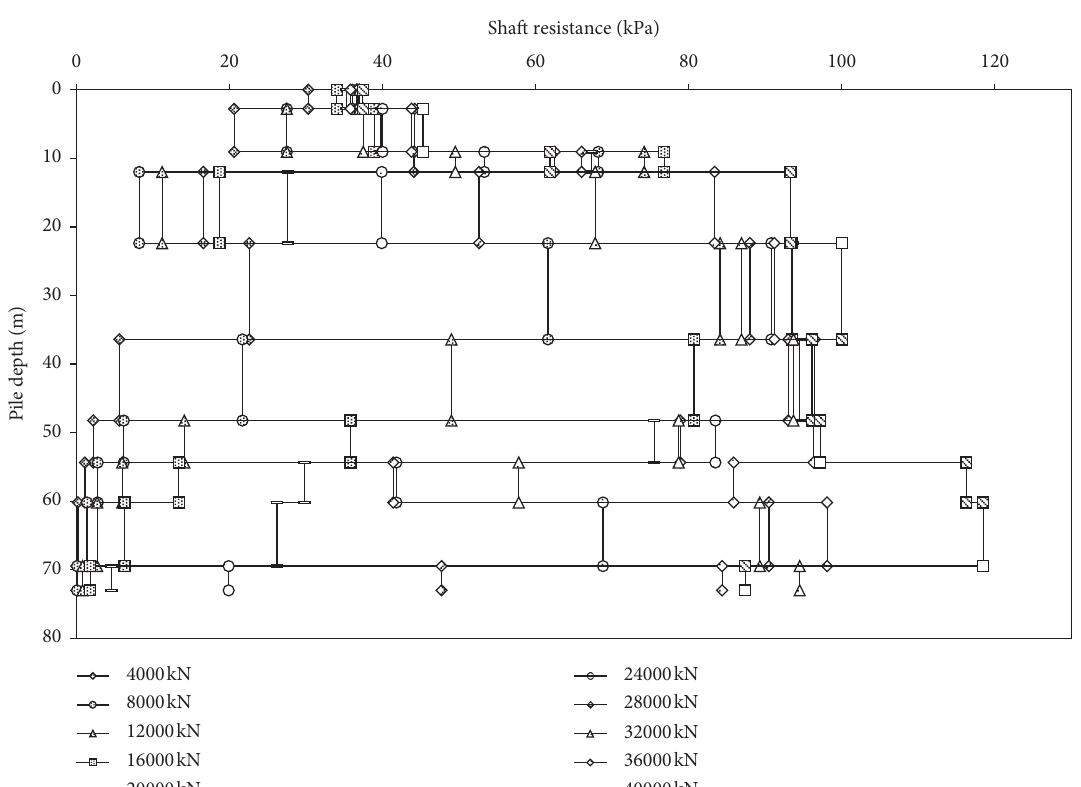
Figure 19: Shaft resistance distribution along the pile for